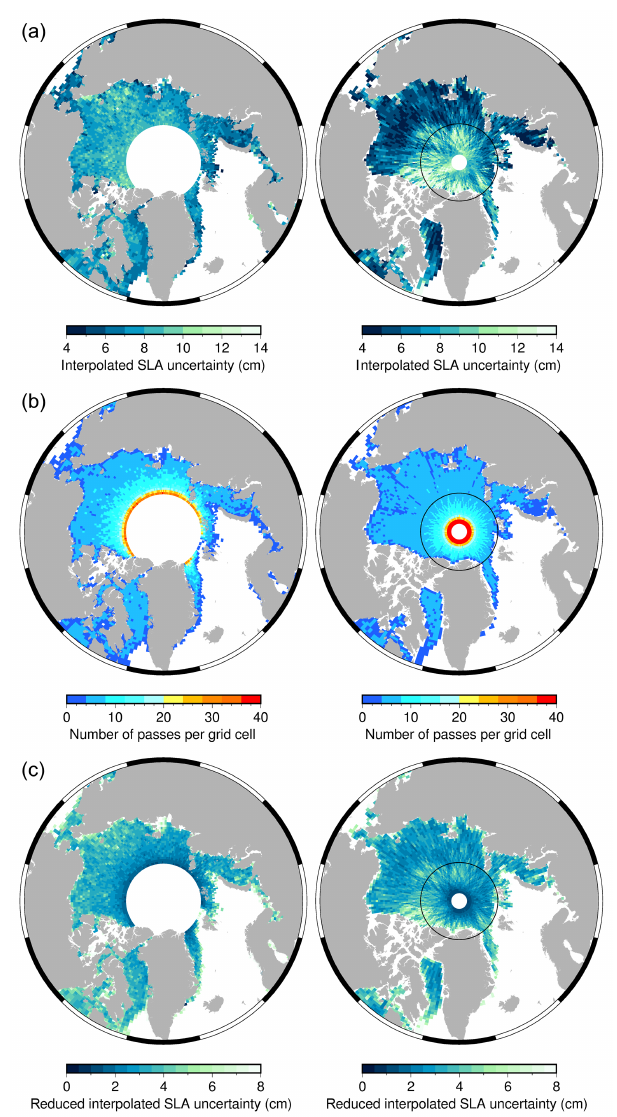
Figure 6. Satellite freeboard error calculation for January 2016 for AltiKa (left) and CS-2 (right). (a) Monthly gridded sea level anomaly (SLA) error. (b) Number of tracks per (1.5 ◦ long × 0.5 ◦ lat) grid cell per month. (c) SLA error divided by the square root of √ the number of tracks, i.e. (a) / (b) gives the reduced monthly error on freeboard. The black circle on the CS-2 maps shows the upper latitude limit of DuST (81.5 ◦ N).